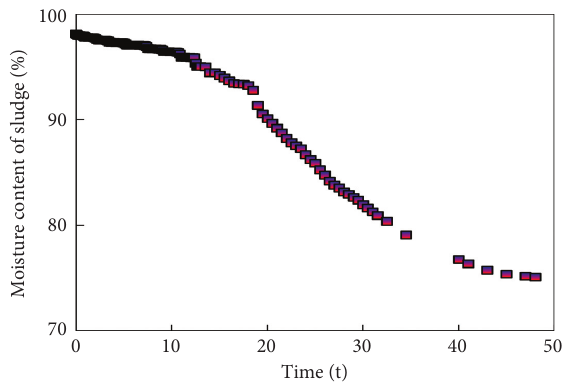
Figure 12: Sludge moisture content without straw.